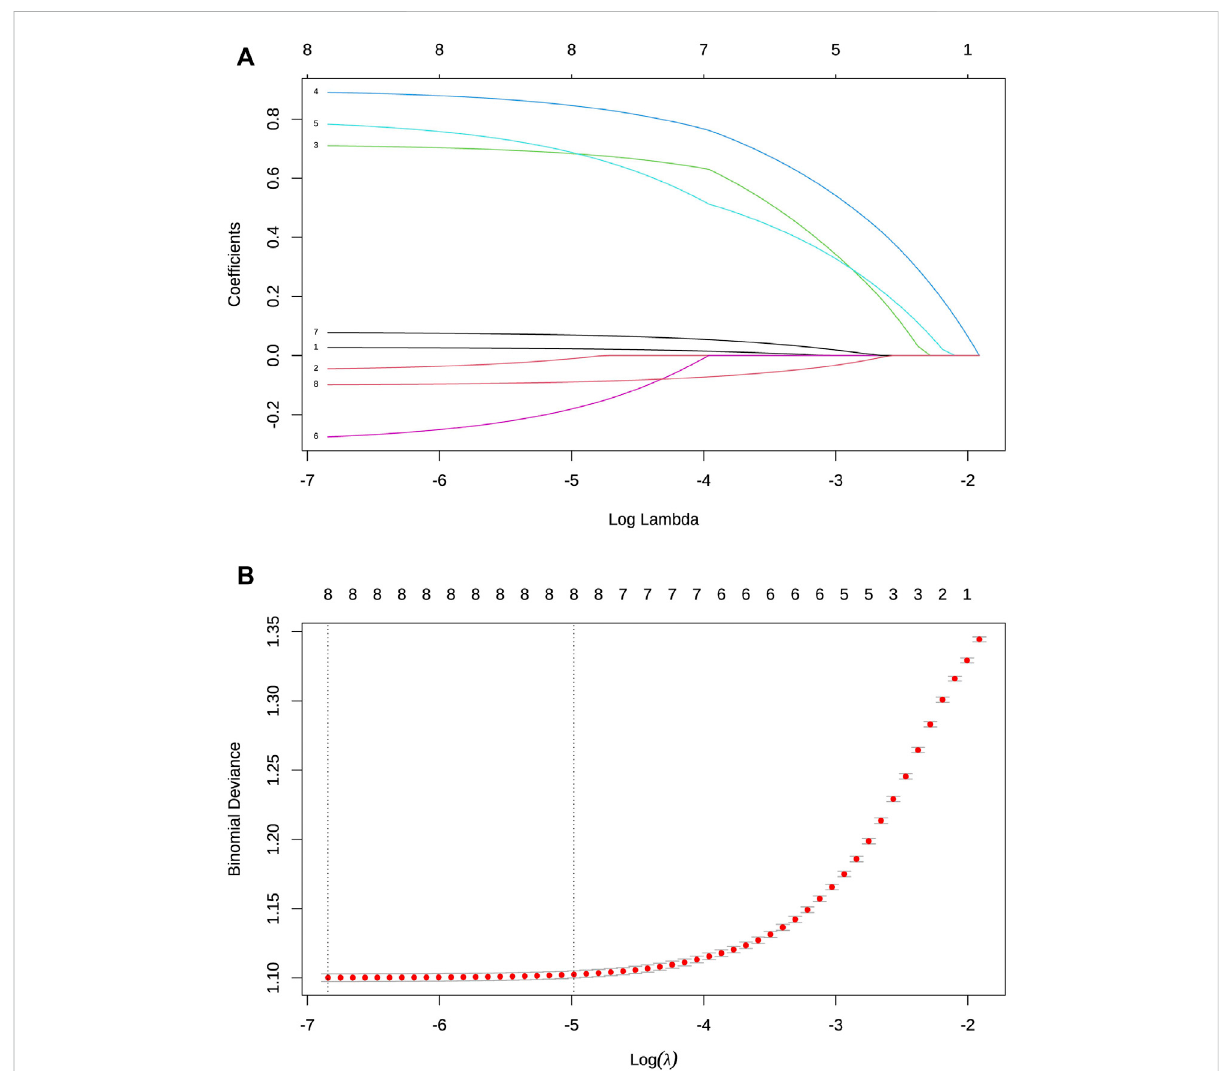
FIGURE 1 Selection of variables by LASSO binary logistic regression model. (A) Each curve in the fi gure represents the shifting track of each independent variable coef fi cient. The y -axis is thevalueof the coef fi cient, the top x -axis islog ( λ ),and thebottom x -axis is thenumber of non-zero coef fi cients in the model at this time. All the eight variables with non-zero coef fi cients were selected by deducing the best λ . (B) Based on cross-validation, each λ value can be used to obtain the con fi dence interval of a target parameter. Two dashed lines indicate two special λ values: one represents the mean value of the minimum target parameter, and the other represents the model with excellent performance but the minimum number of independent